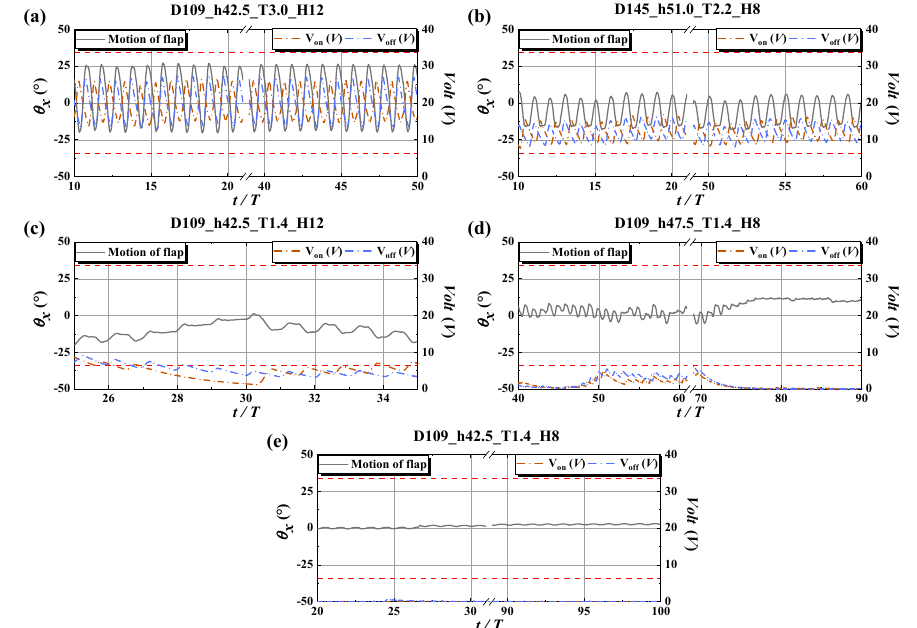
Figure 7. Behavioral characteristics of the flap for ( a ) pattern A (stable), ( b ) pattern B (fluctuation), ( c ) pattern C (unstable), ( d ) pattern D (loss), and ( e ) pattern E ( P wec = 0). Capitals of each subtitle indicate experimental conditions; e.g., D109_h42.5_T3.0_H12 denotes the distance from the reflection wall D (=1.09 m), water depth h (=0.425 m), wave period T (=3.0 s), and wave height H i (=0.12 m). Each pattern is defined as follows: • Pattern A (stable, 108 cases): the flap rotated stably with incident waves.